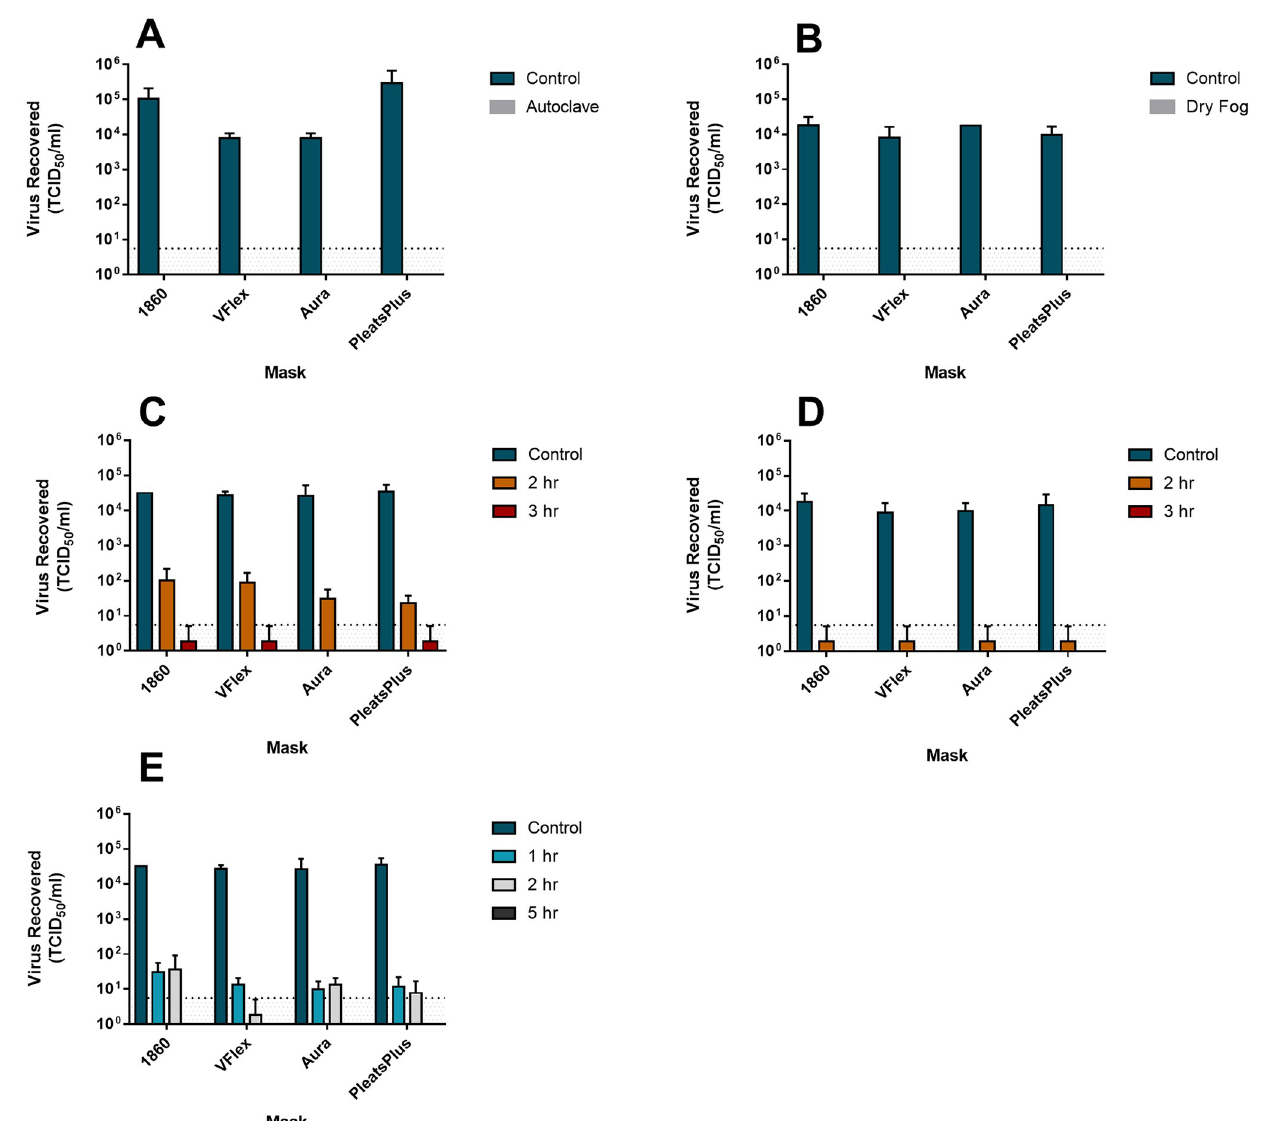
Fig 1. Inactivation efficacy of various decontamination methods against SARS-CoV-2 on experimentally contaminated N-95 masks. Coupons of inoculated N-95 masks (n = 4 models) were subjected to (A) autoclaving at 121˚C for 15 minutes; (B) peracetic acid dry fogging; (C) exposure to 70˚C + 22% RH for 2–3 hours; (D) exposure to 75˚C +22% RH for 2–3 hours; and (E) VHP treatment for 1,2 or 5 hour cycle times. Virus recovery post- treatment was determined by elution of coupons in culture medium and endpoint titration in Vero E6 cells via TCID 50 assay. Inoculated, untreated drying controls of each mask material were included as positive controls in all experiments. Results indicate means +/- standard deviations of three biological replicates. Dotted lines indicate quantification limits of the TCID 50 assay.